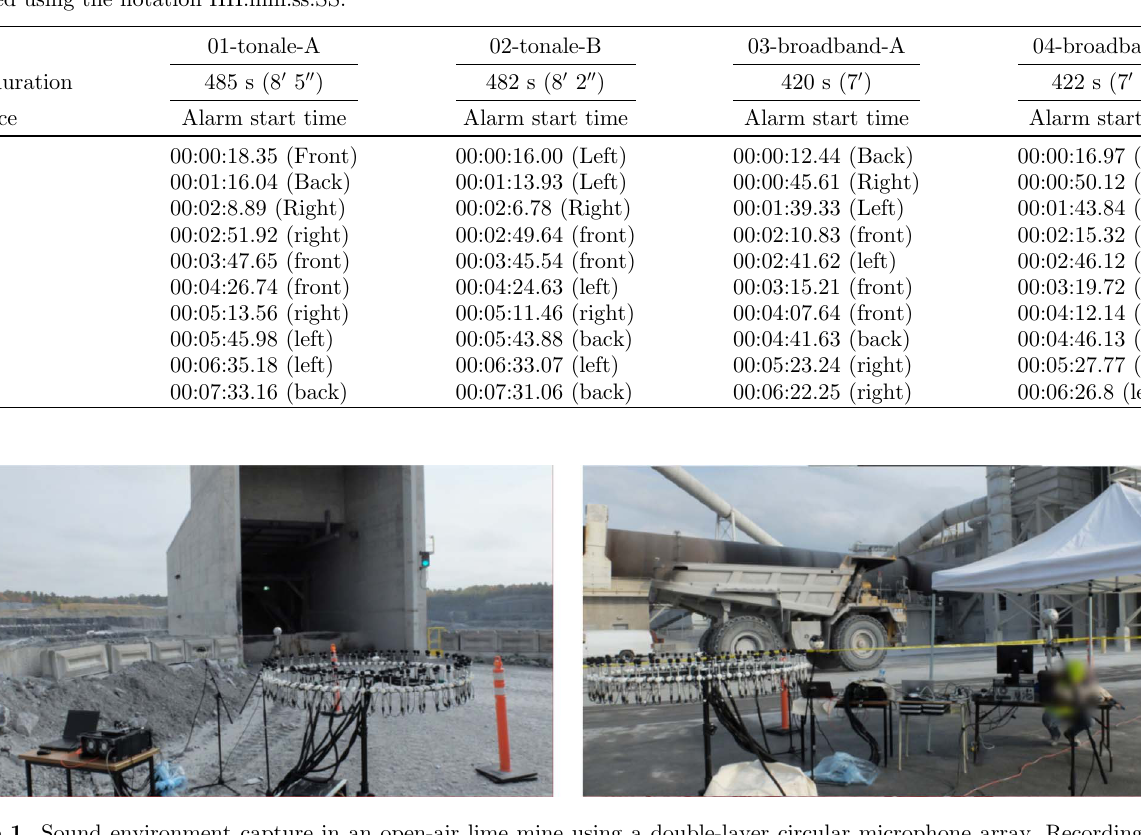
Figure 1. Sound environment capture in an open-air lime mine using a double-layer circular microphone array. Recordings were performed near a mine crusher (left) and with trucks passing at few meters from the array (right), among